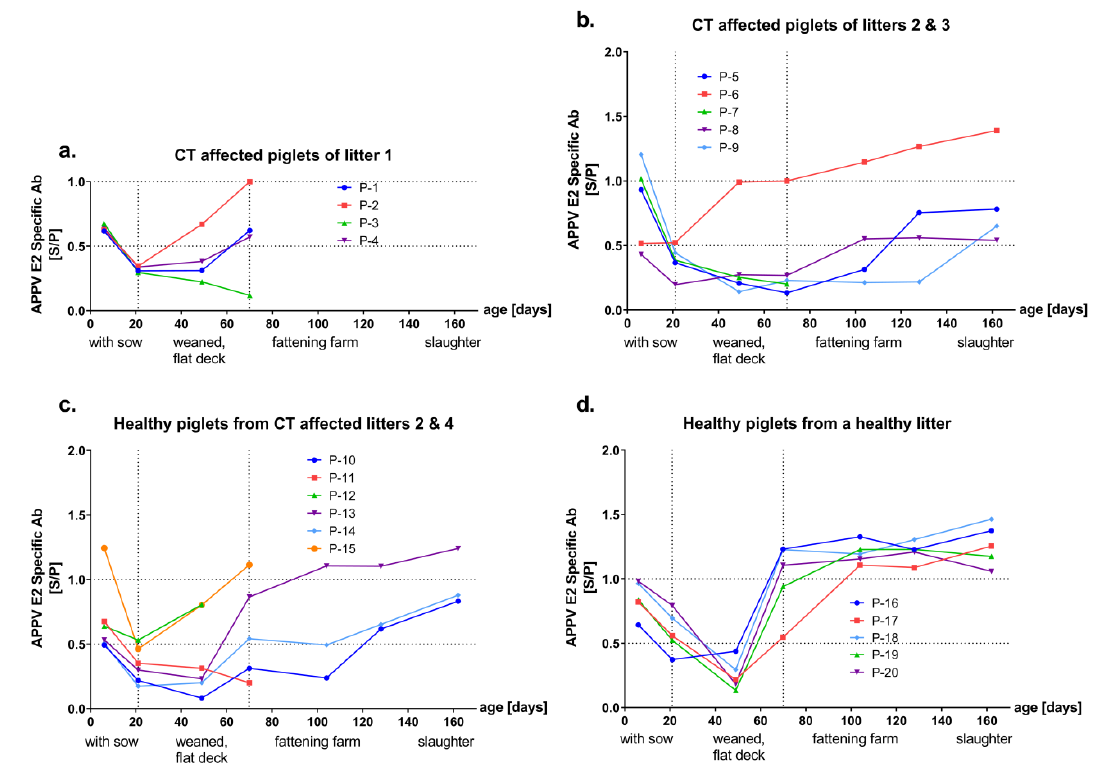
Figure 2. Kinetics of E2-specific antibodies induced after APPV infection. APPV E2-specific antibody levels of 20 pigs were investigated by E2 ELISA and results are given as S/P values (S/P ≤ 0.5, low; S/P = 0.5–1.0 intermediate; S/P ≥ 1.0 high reactivity). Horizontal dashed lines indicate the APPV E2-specific Ab levels as low, intermediate and high. Vertical dashed lines indicate the changes in the holding conditions. Piglets from CT affected litter 1 ( a ) were cross-fostered immediately after birth to a pluriparous sow with a healthy litter. Piglets from CT affected litters 2, 3 and 4 are grouped into two panels ( b,c ) by the occurrence of CT.